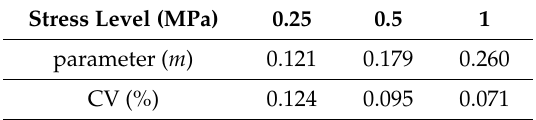
Figure 8. The regression results with stress levels of 1 MPa. Table 9. Dynamic modulus decay parameter m under different stress levels.